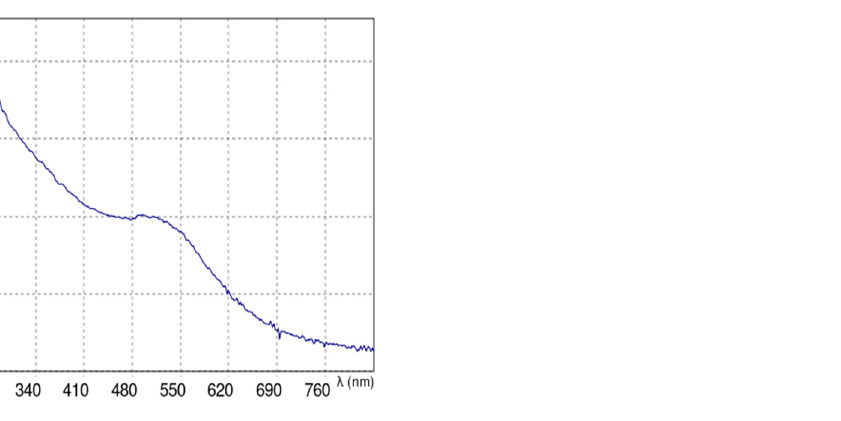
Figure A8. Absorption spectrum of AuNP-RGD 7 after dialysis (A spr = 0.399/A 480 = 0.389 give 1.02 → 3 nm).